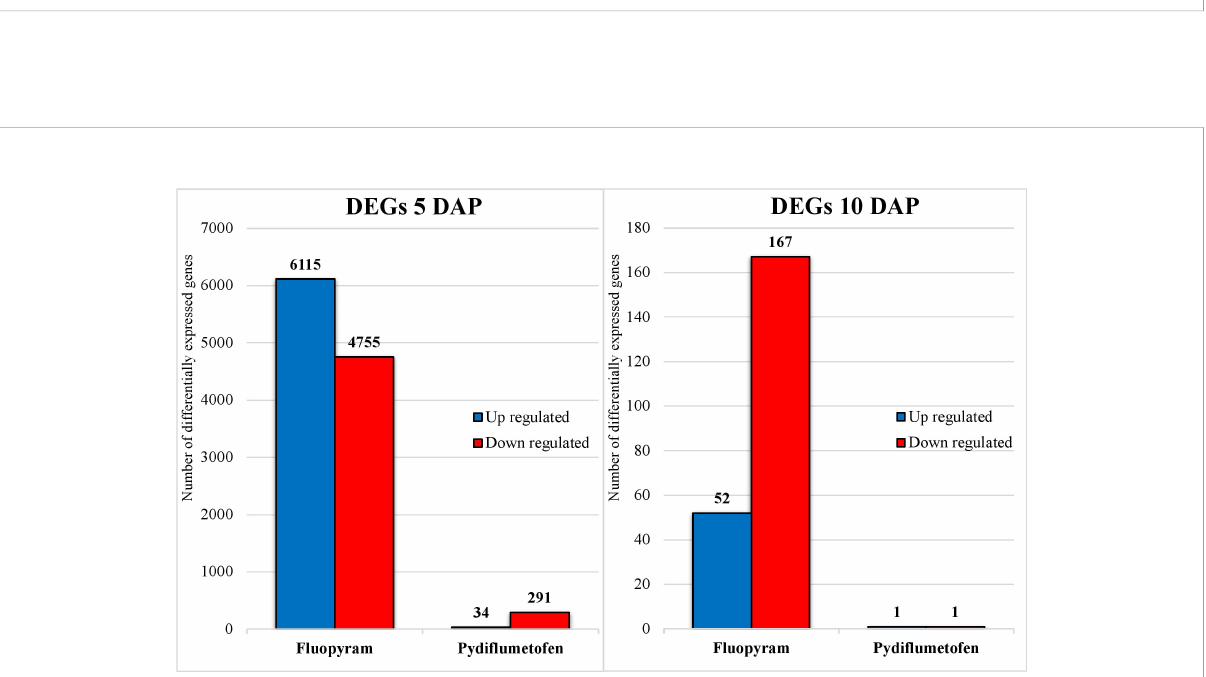
FIGURE 3 Number of differentially expressed genes (DEGs) up and downregulated in soybean seedlings treated with fl uopyram and pydi fl umetofen, 5 and 10 days after planting (DAP). All gene expression levels were compared to their respective non-treated control (5DAP or 10 DAP). Genes were considered differentially expressed when having Padj<0.05, regardless of fold change